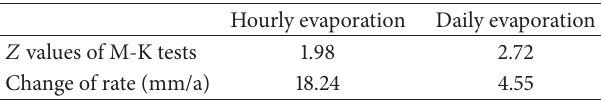
Table 1: 𝑍 values of the M-K trend tests for total annually hourly and daily evaporation in Dongping Lake during 2003–2010.